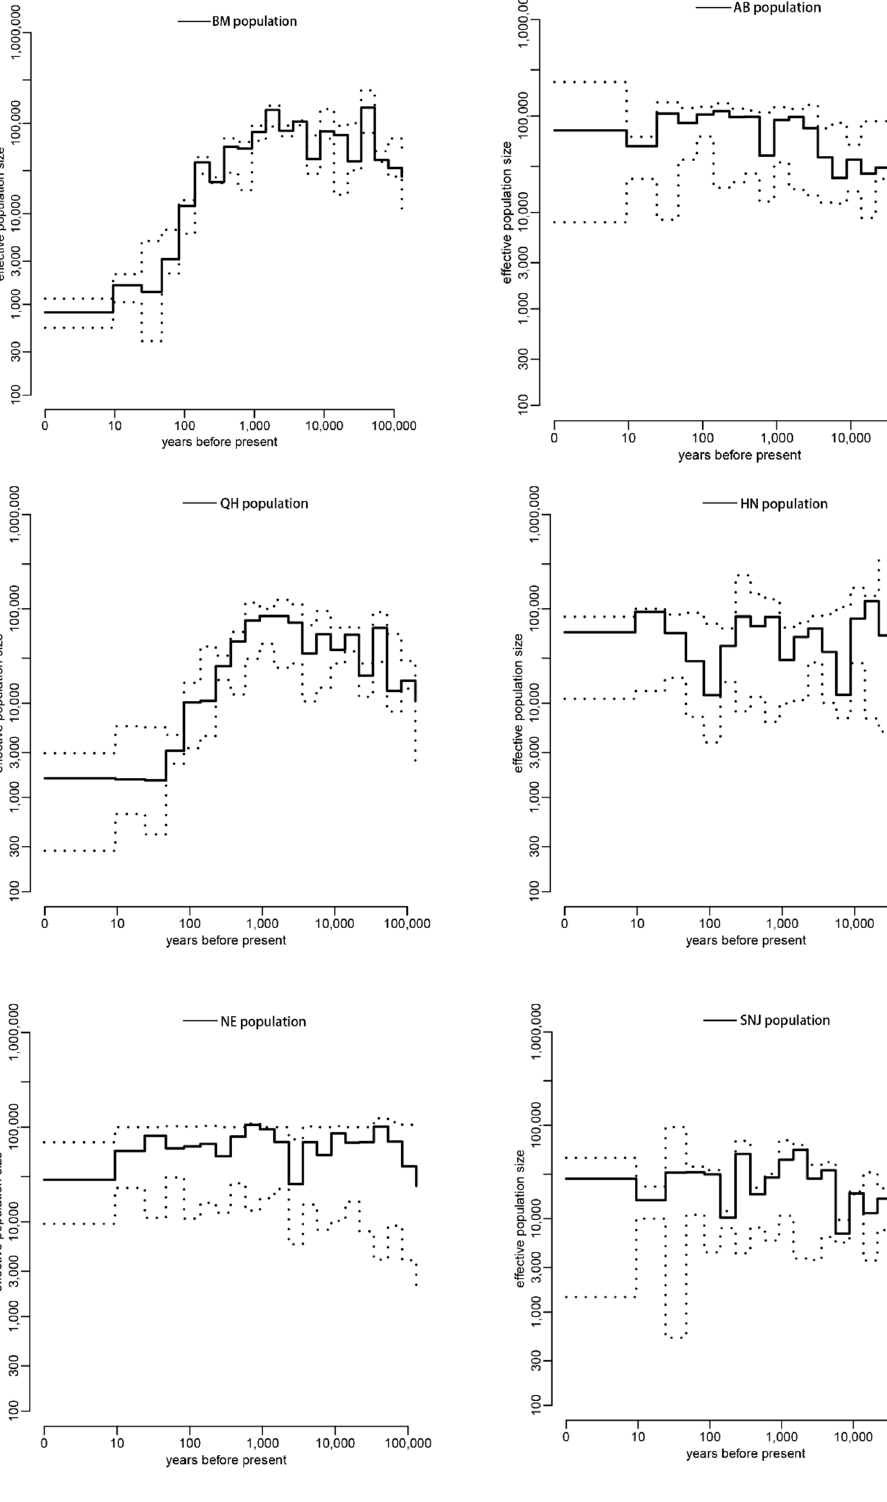
Figure 3. The recent effective population size ( Ne ) for each population group inferred by software PopSizeABC. A 95% credible interval is indicated by dotted lines.